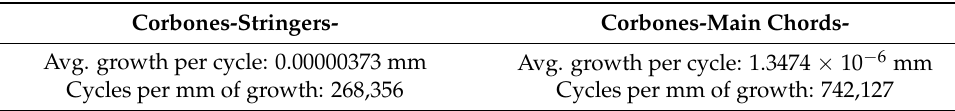
Table 5. Results (Corbones): Avg. growth per cycle, cycles per mm of crack